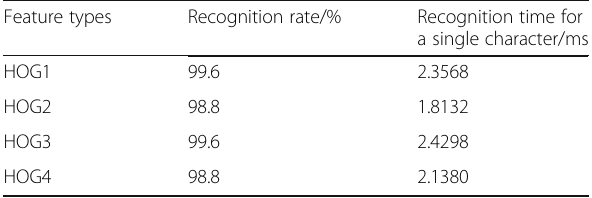
Table 2 Comparison of recognition performance under different feature conditions with BP neural network Feature types